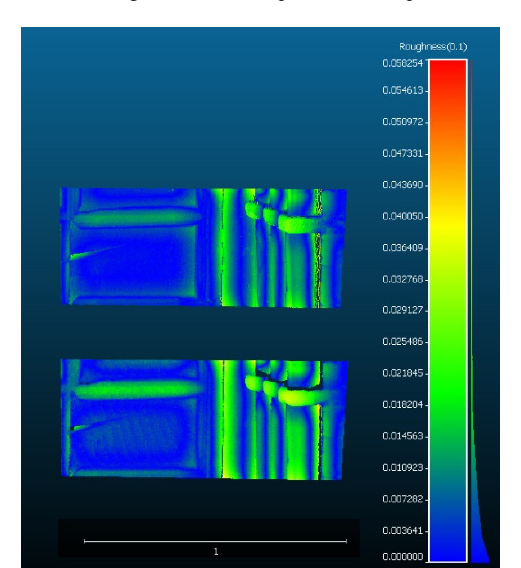
Figure 5. Comparison of different sections automatically extracted from the two point